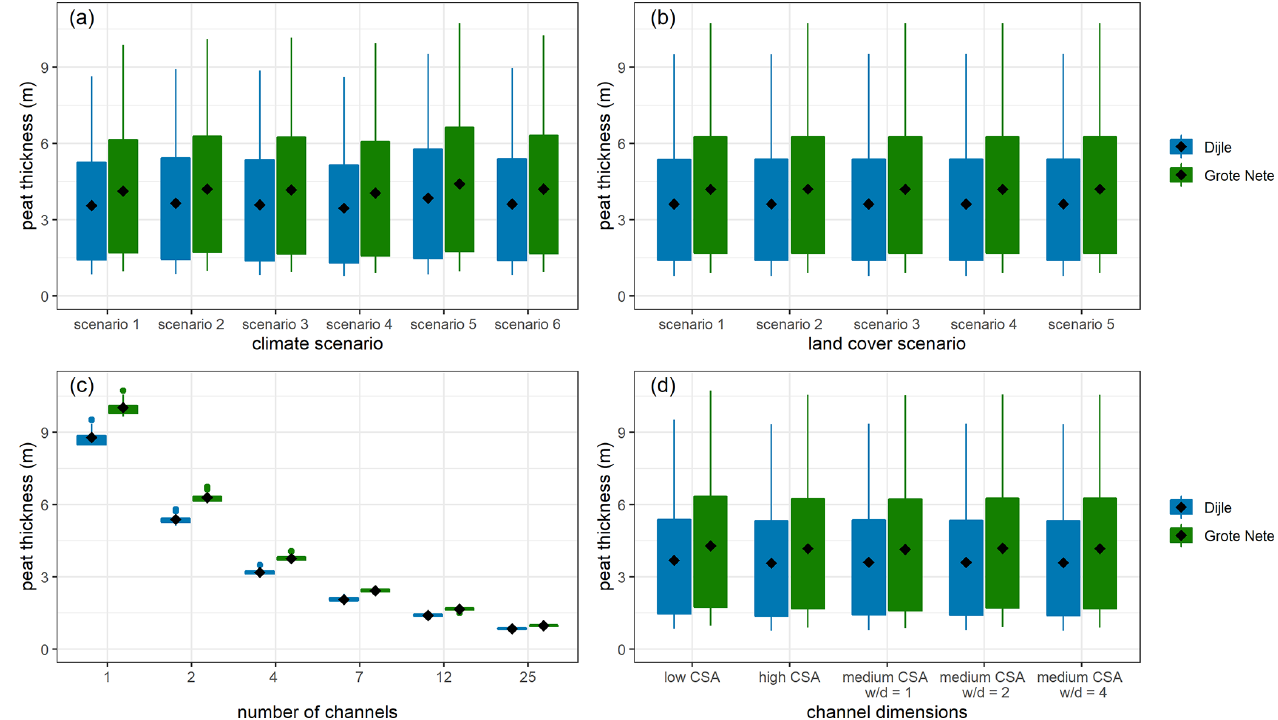
Figure 9. Boxplots of the simulated peat thickness (m) for all scenario combinations over a time period of 10000 years for the Dijle and Grote Nete rivers, subdivided per climate scenario (a) , land cover scenario (b) , number of channels (c) and channel dimensions (d) . The mean value is indicated by a black diamond. The box indicates all values within the 25th to 75th percentile range, and the whiskers represent all values within the range from the 25th percentile to 1.5 times the interquartile range to the 75th percentile plus 1.5 times the interquartile range. Coloured dots represent all other values outside this